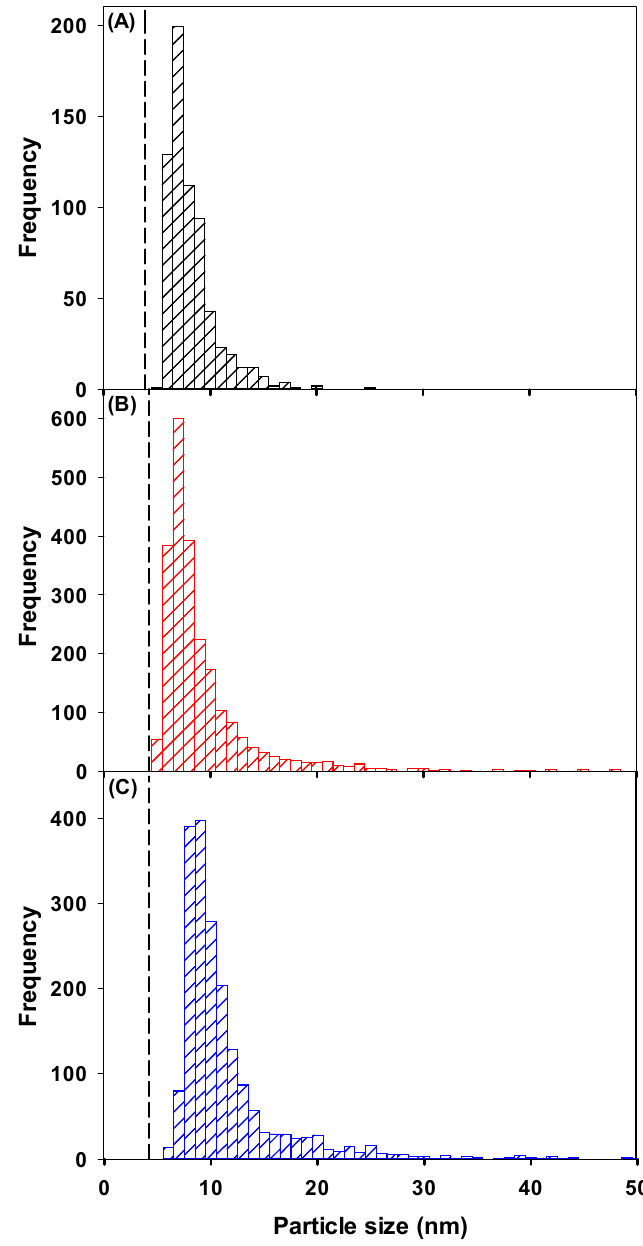
Figure 3. Particle size distribution of a suspension of CeO 2 NPs with a nominal size of 1–10 nm. NP were spiked into ( A ) Milli-Q water or ( B ) rainwater. ( C ) Particle size distribution for Ce-containing NPs in rainwater, determined under the assumption that they were spherical CeO 2 NPs with a density of 7.13 kg dm − 3 [23]. The dashed line corresponds to the SDL. The mean particle size ± polydispersity of the CeO 2 NPs was ( A ) 11.0 ± 5.8 nm; ( B ) 7.7 ± 2.4 nm and ( C ) 9.2 ± 6.1 nm. Measurements were obtained using the wet-SF-ICP-MS with a 50 µ s dwell